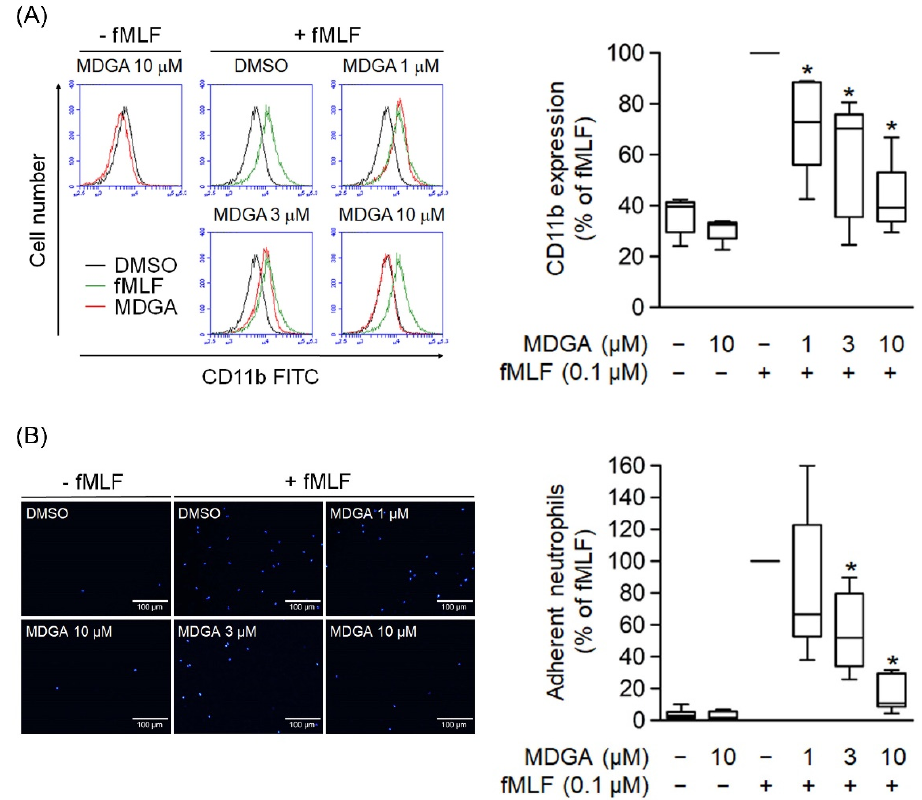
Figure 5. meso -Dihydroguaiaretic acid (MDGA) inhibits human neutrophil CD11b expression and adhesion. ( A ) After incubation with DMSO (0.1%, black line) or MDGA (1, 3, and 10 µ M, red line), human neutrophils were stimulated by fMLF (green line). The mean fluorescence intensity was quantified and shown in the right panel. ( n = 5). ( B ) Neutrophils were first stained with Hoechst 33342 and then incubated with DMSO (0.1%, as control) or MDGA (1, 3, and 10 µ M) before fMLF activation. Stimulated neutrophils were co-cultured with bEnd.3 cells and the numbers of